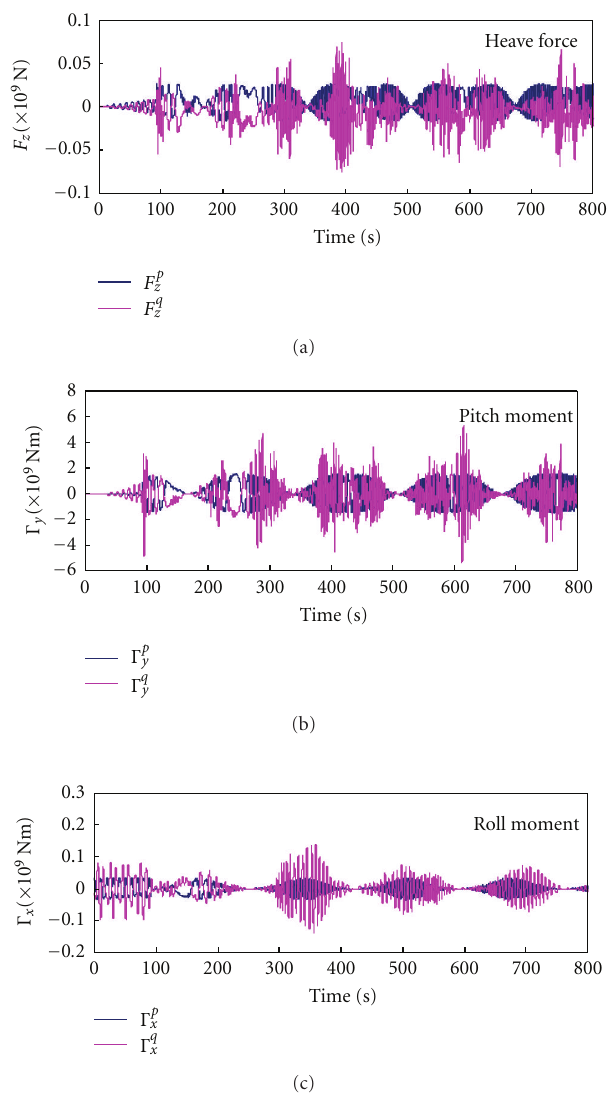
Figure 1: The numerical driving and restoring forces (moments) for heave (a), pitch (b), and roll (c) from the original DiSSEL. The ship hull is EHF, with a rudder angle δ = 15 ◦ and the Froude number F r = 0 . 266. The incident wave height is wh = 1 . 496 m, and its wavelength normalized by ship length is λ = 1 . 0 (Case 1). The superscripts “ p ” and “ q ” represent the driving forces (moments) and restore forces (moments) which associated with (4c), (4d), and (5c), and